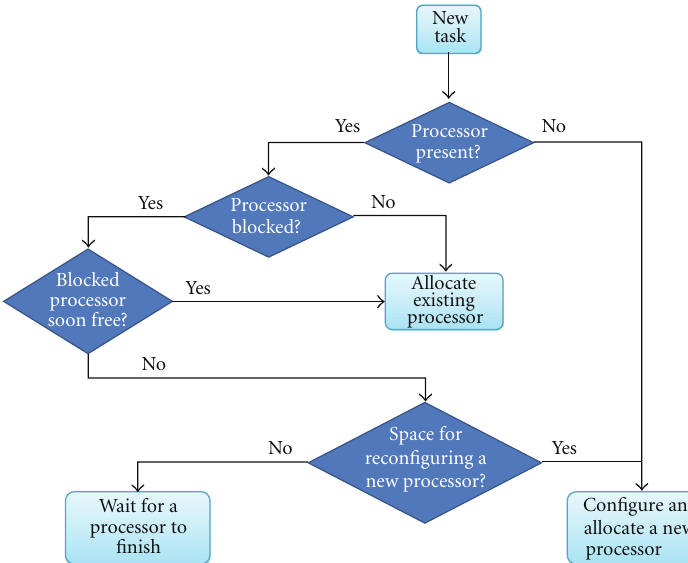
Figure 7: Decision tree for resource allocation for an SW